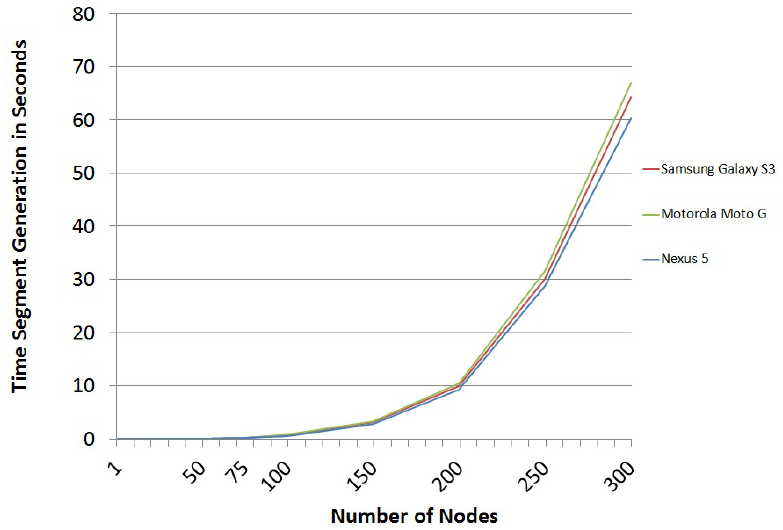
Figure 6. Segment generation time